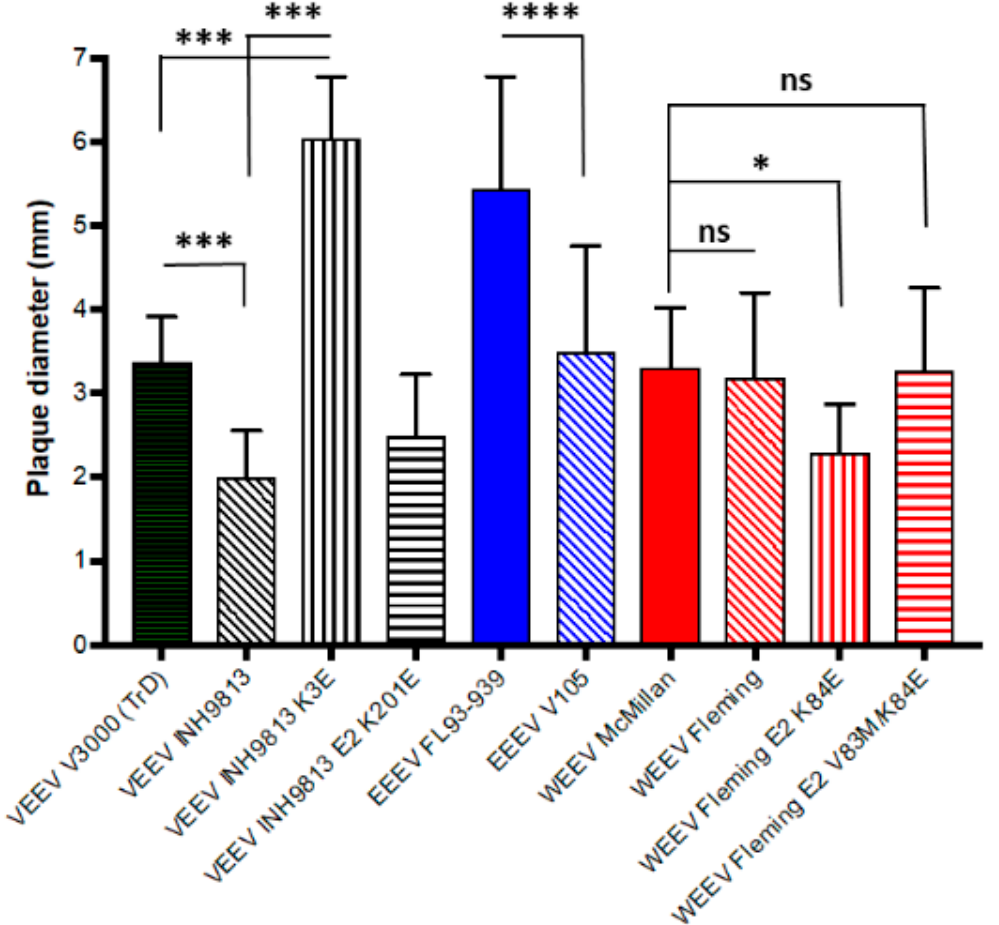
Figure 4. Plaque sizes of cDNA clone-derived viruses on BHK cells. Plaque assays were performed as described in Materials and Methods and 60 plaques in three wells were counted for each virus. VEEV—black bars, EEEV—blue bars, WEEV—red bars. Error bars are standard deviations. Significance denoted with asterisks or ns if not significant (ns p > 0.05, * p < 0.01, *** p < 0.0001, **** p < 0.00001 ).